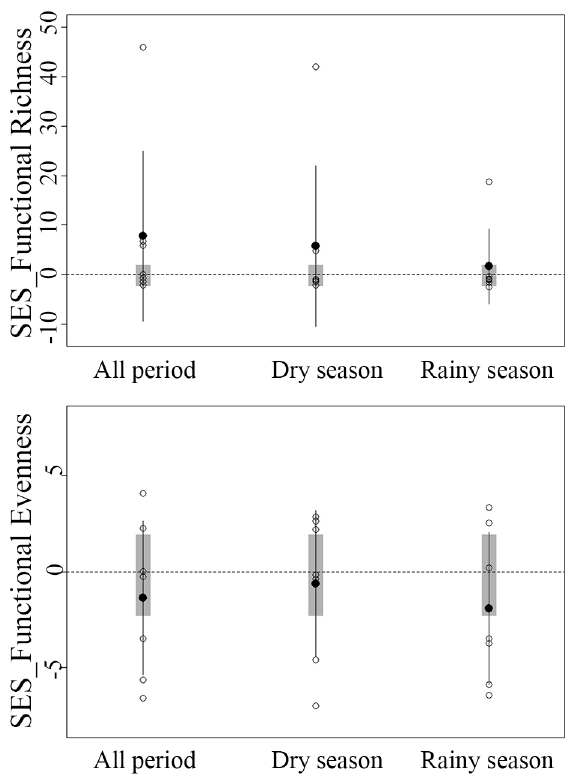
Figure 4. Variation of standardize effect size (SES) for functional diversity metrics among lizard communities of Nhumirim Ranch, Pantanal Brazil. Black dots and segments: mean and standard deviation of community values, gray box: distribution under a null